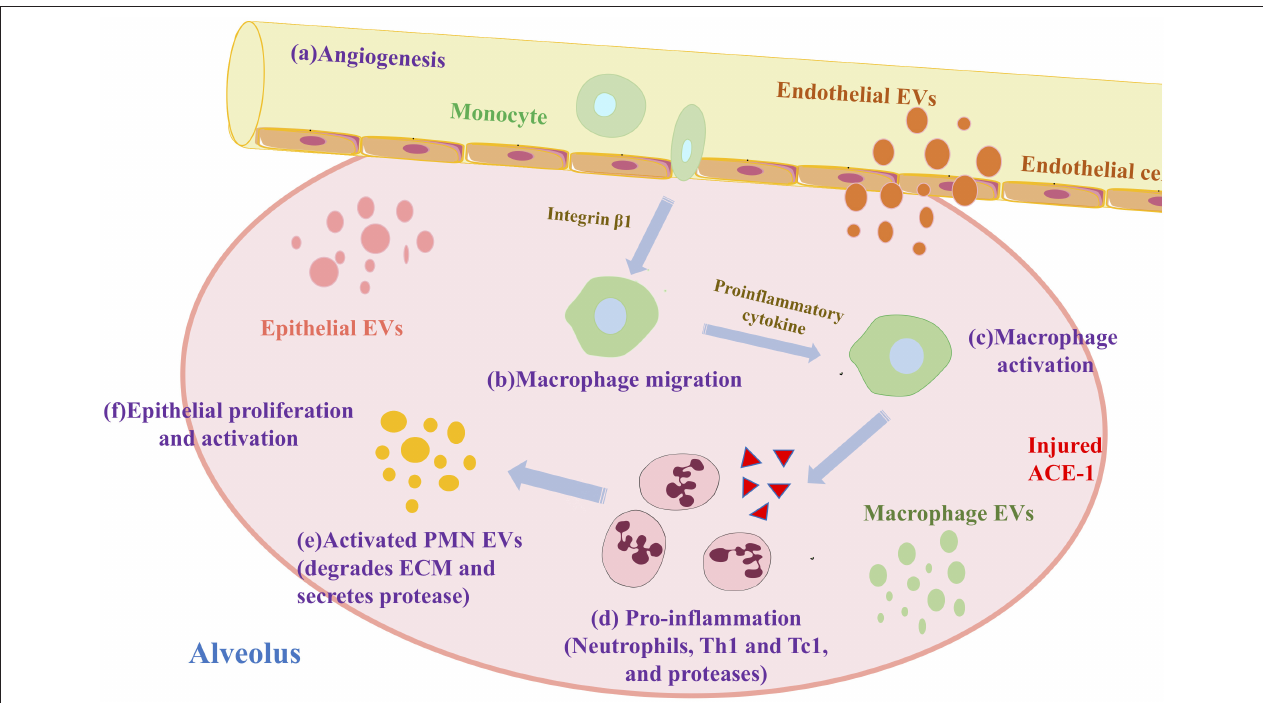
FIGURE 3 | Exosomes and macrophages promote alveolar inflammation in